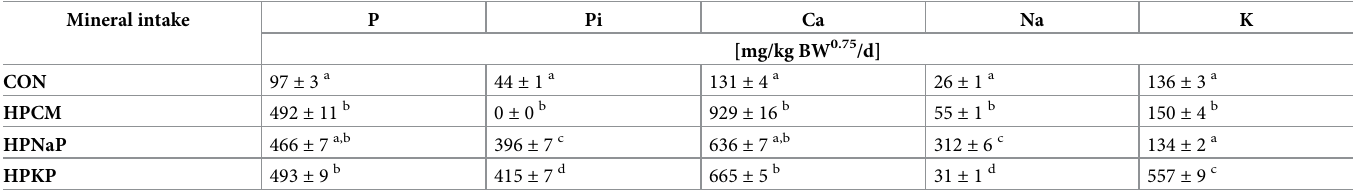
Table 3. Absolute amount of major mineral intake [mg/kg BW 0.75 /d] in dogs fed a control (CON) and 3 high phosphorus diets, containing either poultry carcass meal (HPCM), NaH